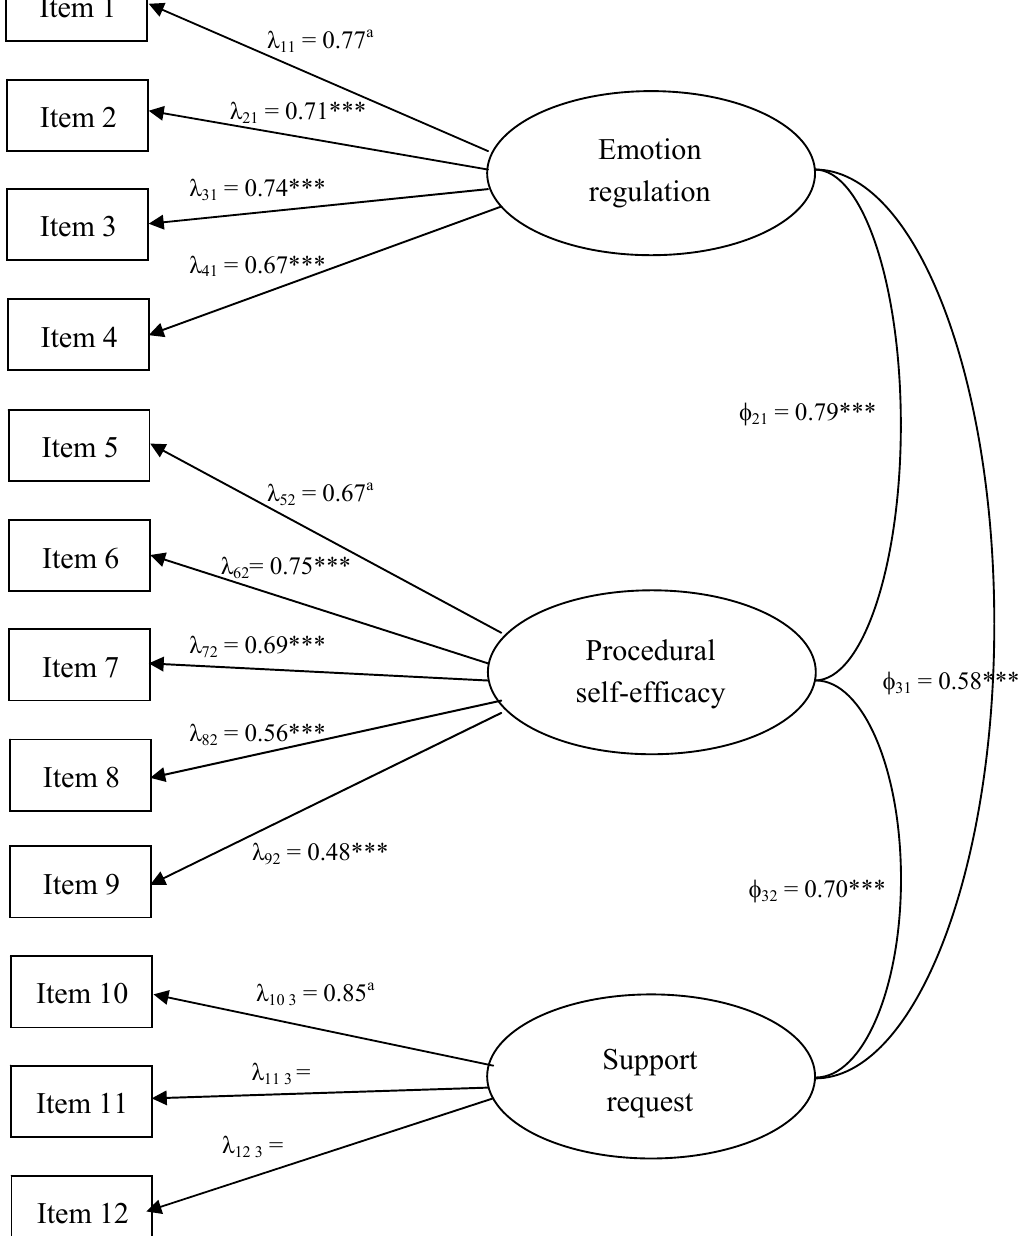
Figure 1. The three factor structure of SESSW (confirmatory factor analysis; CFA).